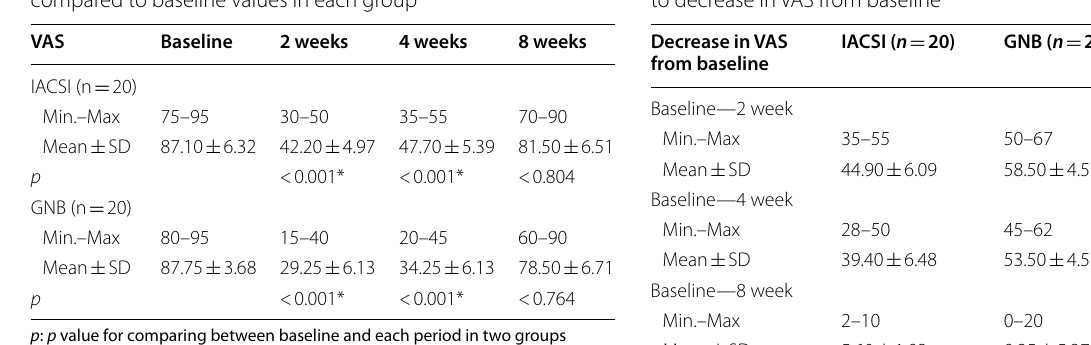
Table 4 Comparison between GNB and IACSI groups according